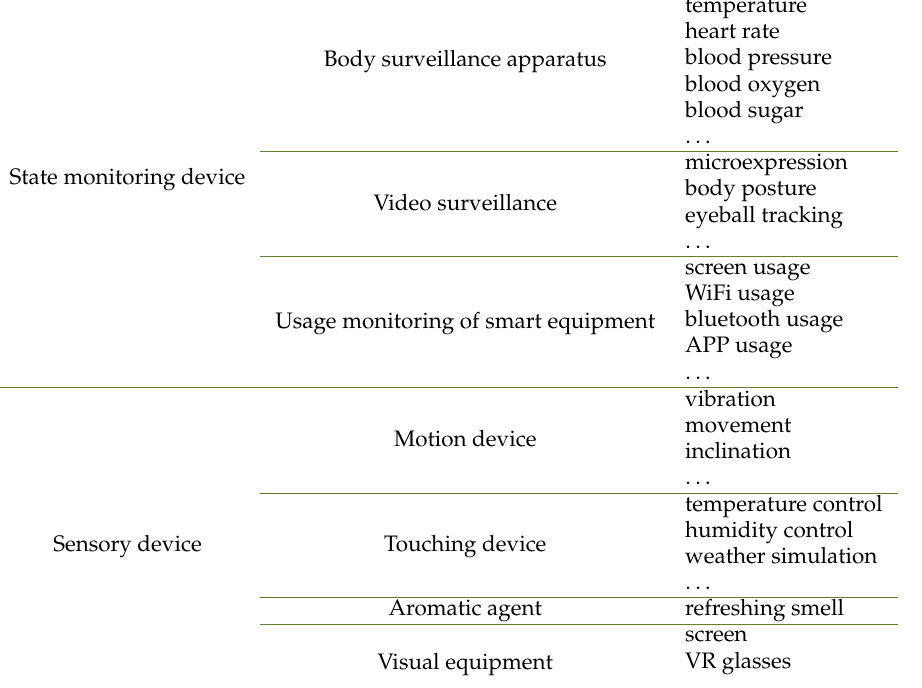
Table 1. Common multidimensional interactive